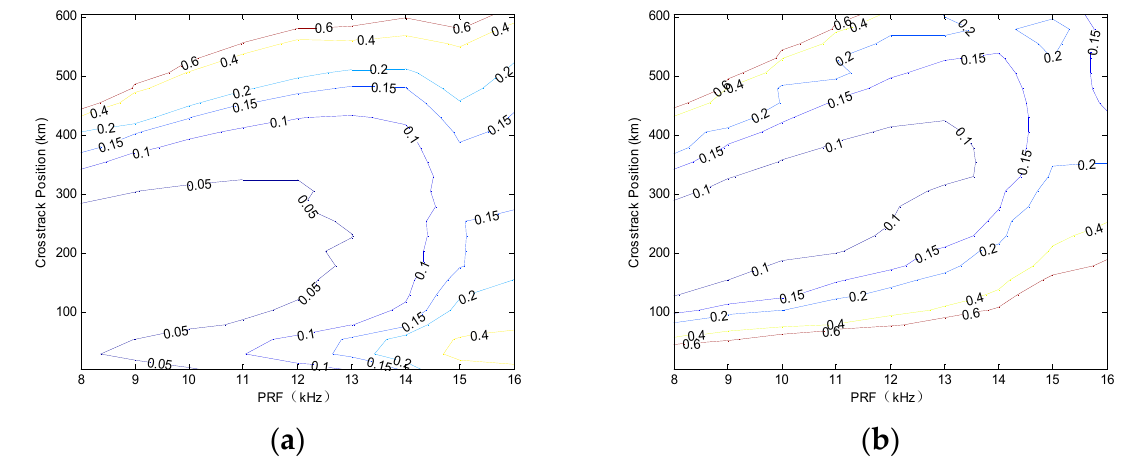
Figure 15. Current velocity components Std with PRF for a wind speed of 7 m/s and a wind direction of 90°: ( a ) along-track direction; ( b ) cross-track direction. Table 3. Current field effective swaths of different current velocity Stds with different values of PRF. PRF (kHz)/Current Velocity Std (m/s)